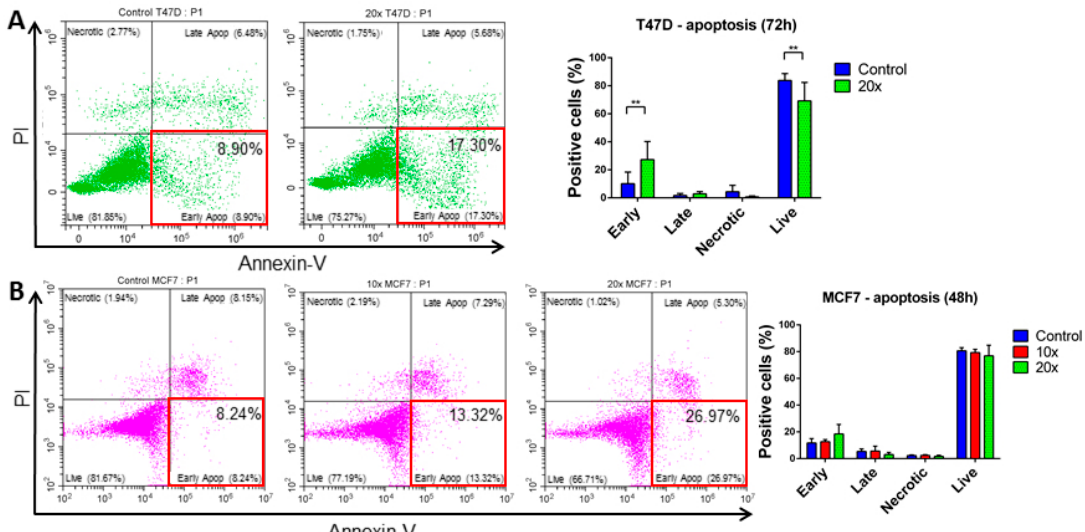
Figure 3. Apoptosis detection in T47D and MCF7 cells. Early apoptotic cells (Early; red square highlighted areas, lower right squares) of T47D were increased significantly ( A ) compared to controls after 72 h methyl-donor treatments, while MCF7 showed only a tendency of increase after 48h ( B ). Each bar represents the average percentage of positive cells in early apoptotic, late apoptotic, necrotic, and live cells area from at least 3 repeats ± SD. Statistical significance was plotted as